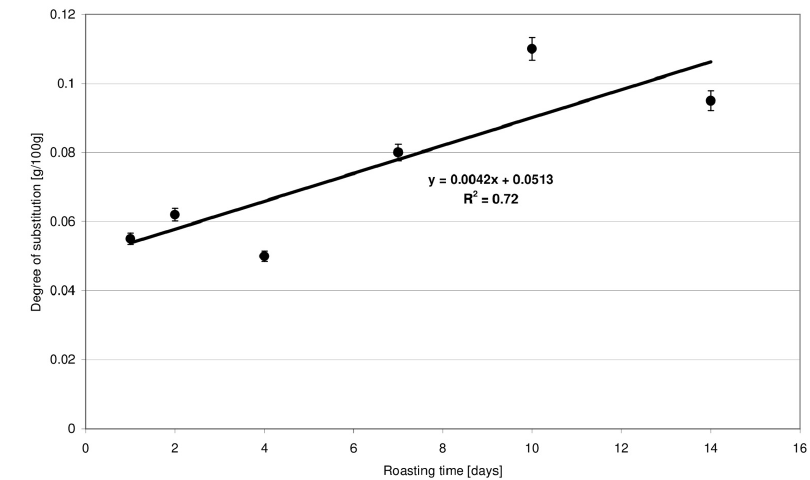
Figure 1. Effect of the time of starch retention with citric acid on the degree of substitution of modified starch preparations.